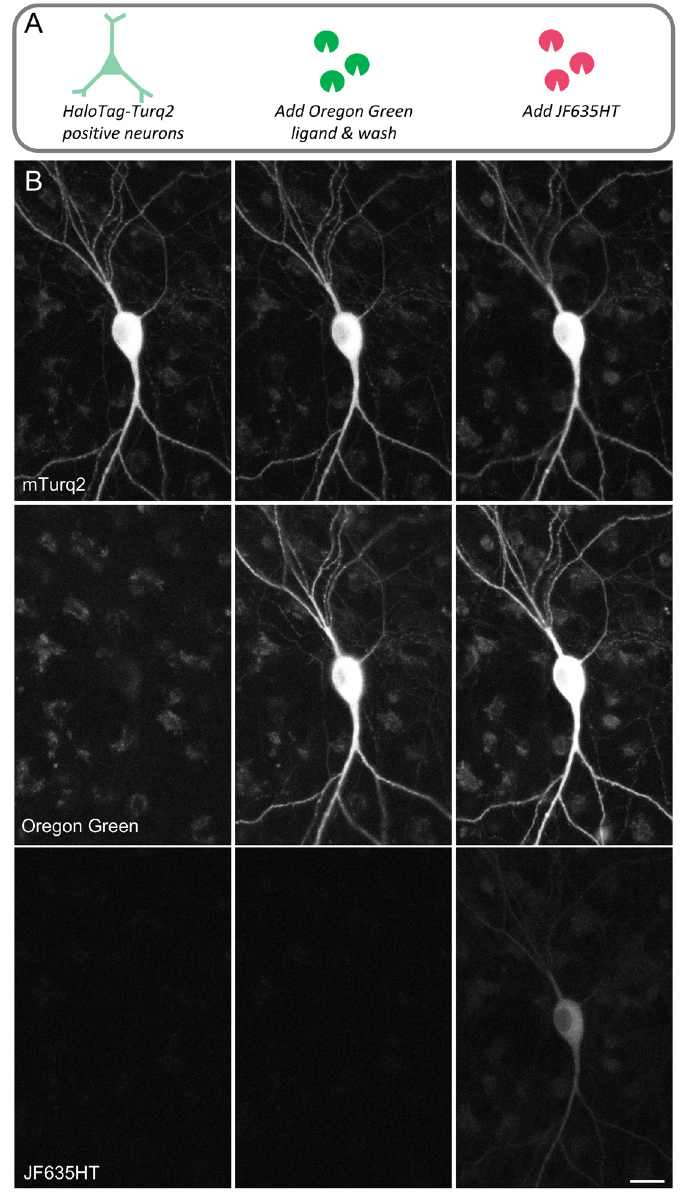
Figure 3. Significant residual free binding sites after conventional labeling with fluorescent HaloTag ligand. ( A ) mTurq2-positive neurons in cell culture were labeled with Oregon Green HaloTag ligand (Promega 100nM, 1 hour), washed, and labeled immediately with JF635HT ligand. ( B ) Applying JF635HT resulted in significant labeling, indicating incomplete saturation of HaloTag binding sites. JF635HT labeling occurred also when using a 10-fold higher concentration of Oregon Green (Promega 1 µM, 1hour; not shown). Bar,